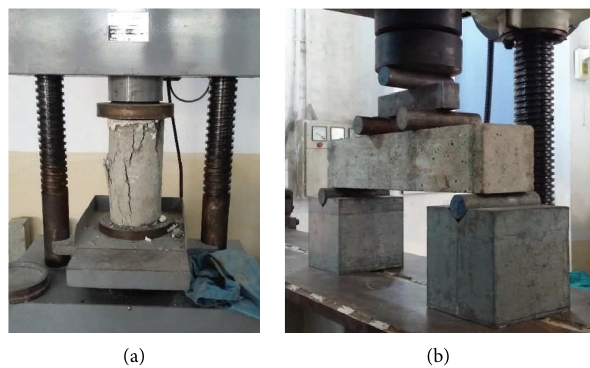
Figure 4: Testing setup: (a) compressive strength test and (b) fexural strength